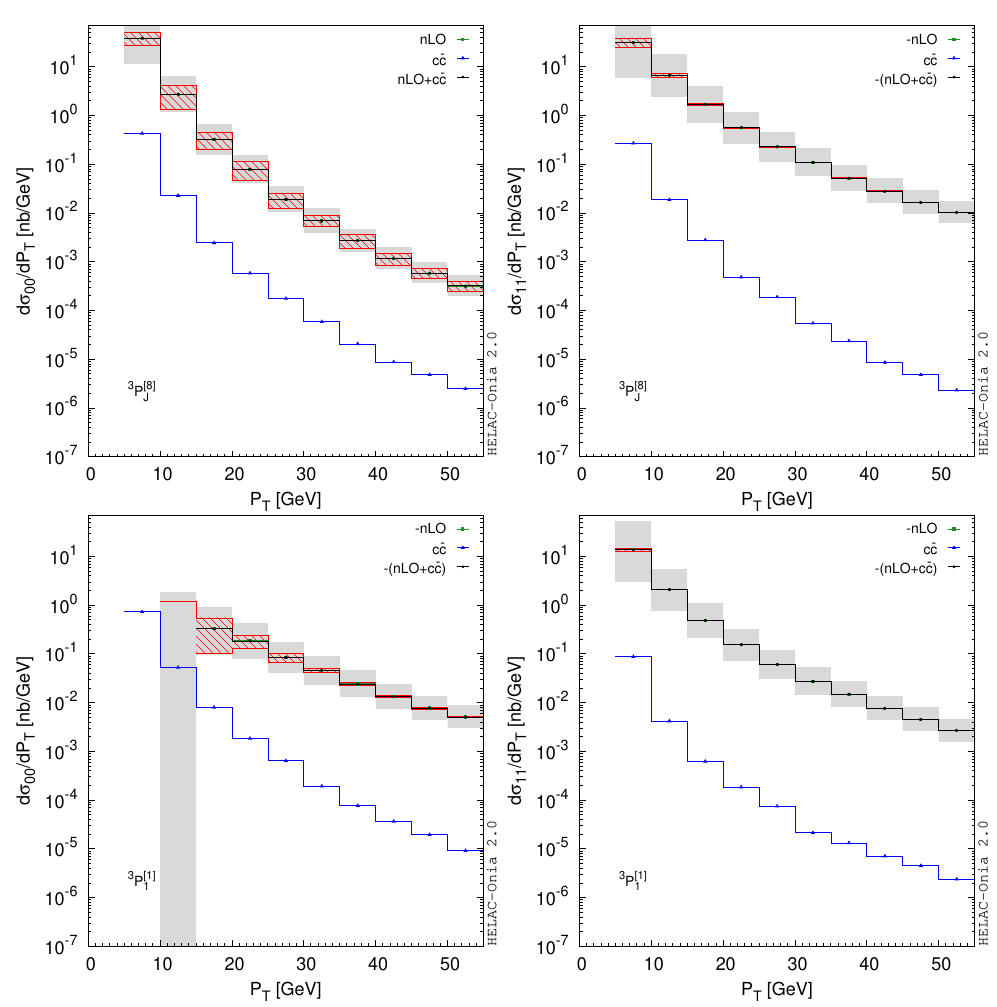
Figure 25 . Comparisons of spin-dependent differential cross sections d(cid:27) 3 P [8] between our nLO calculations and the LO charmonium plus charm quark pair calculations. ; 3 P [1] 1 J They are similar to figure